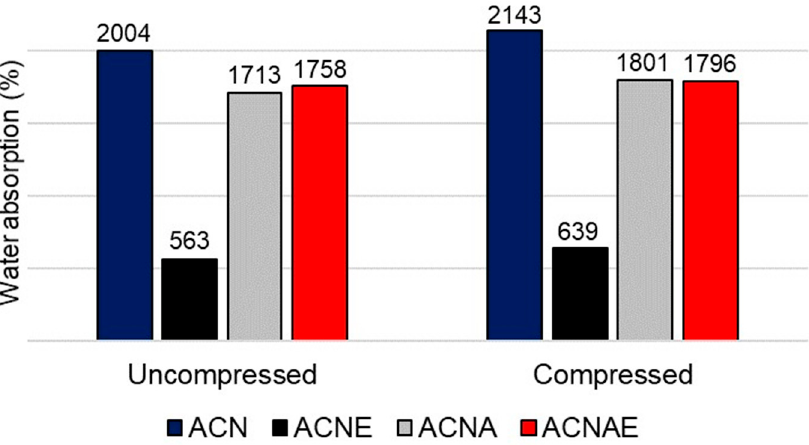
Figure 6. Water uptake of the NFC-based aerogels.